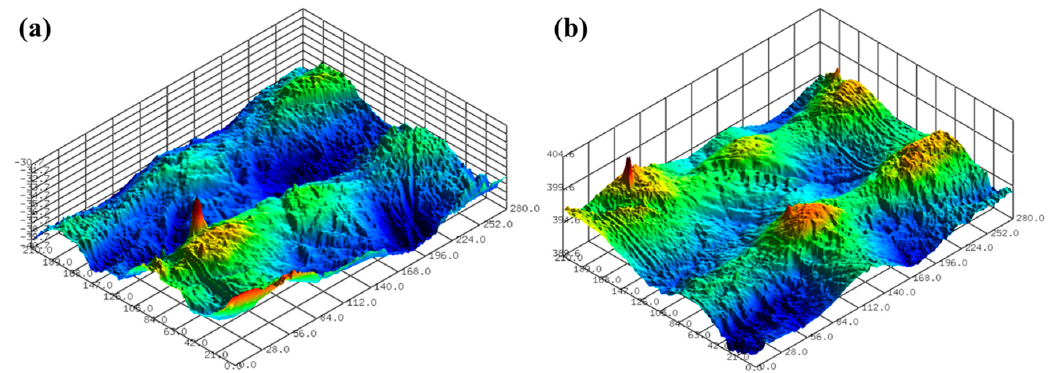
Figure 2. Surface profiles after SLA 3D printing; ( a ) Sa of 1.002 µ m and Sz of 8.947 µ m, and ( b ) Sa of 1.065 µ m and Sz of 9.401 µ m.